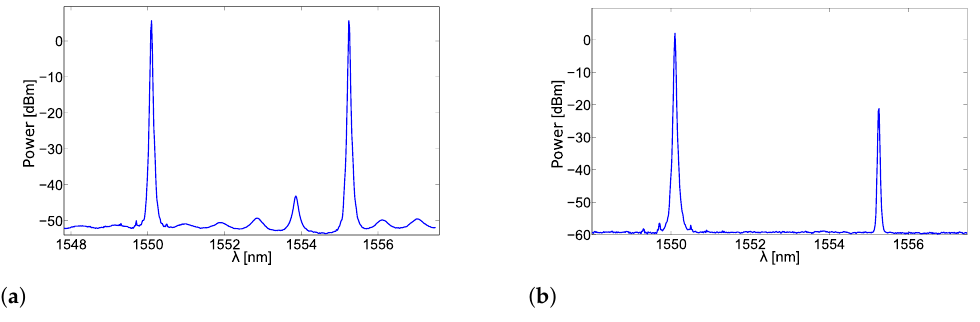
Figure 3. Spectra of the multiplexed ( a ) and demultiplexed ( b )